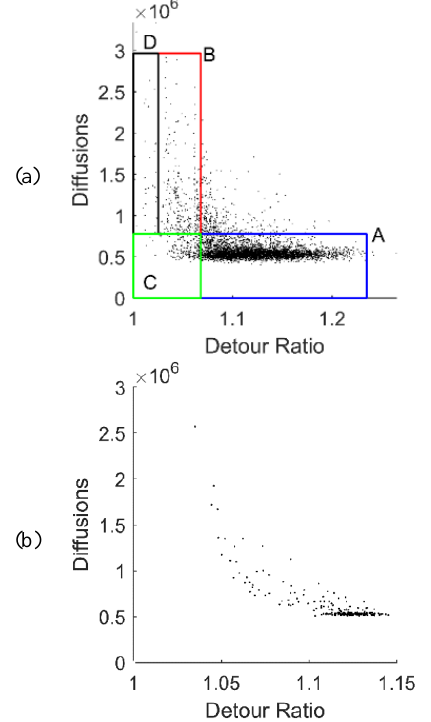
Figure. 3. Results of experiment #1. a) The results of all 4800 practices, b) Average of all 10 practices of each variant of the algorithm.